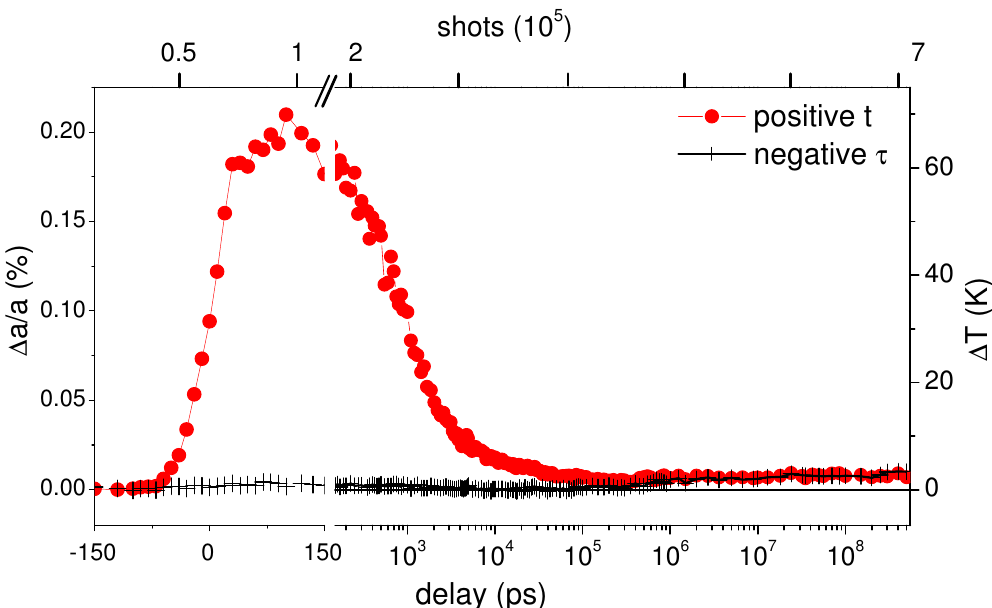
Figure 4. Lattice thermal expansion of a gold film on top of a natural silicon wafer as function of delay between laser and X-ray probe pulse. The circles mark an acquisition, where the delay has been constantly increased after each measuring point, while the delay has been kept constant at − 2 ns for the data with crosses, but directly preceding the acquisition with varied delay. The corresponding number of laser shots accumulated on the illuminated spot is marked on the top axis.